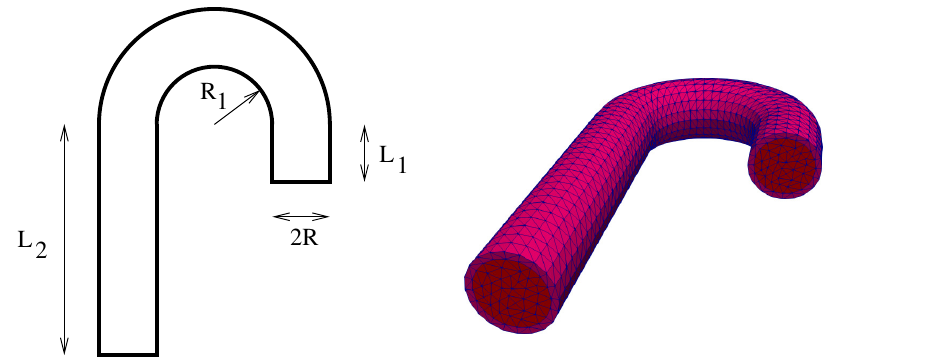
Figure 5. The parameters of the fluid domain ( left ); and a global mesh for fluid–structure domain ( right ).